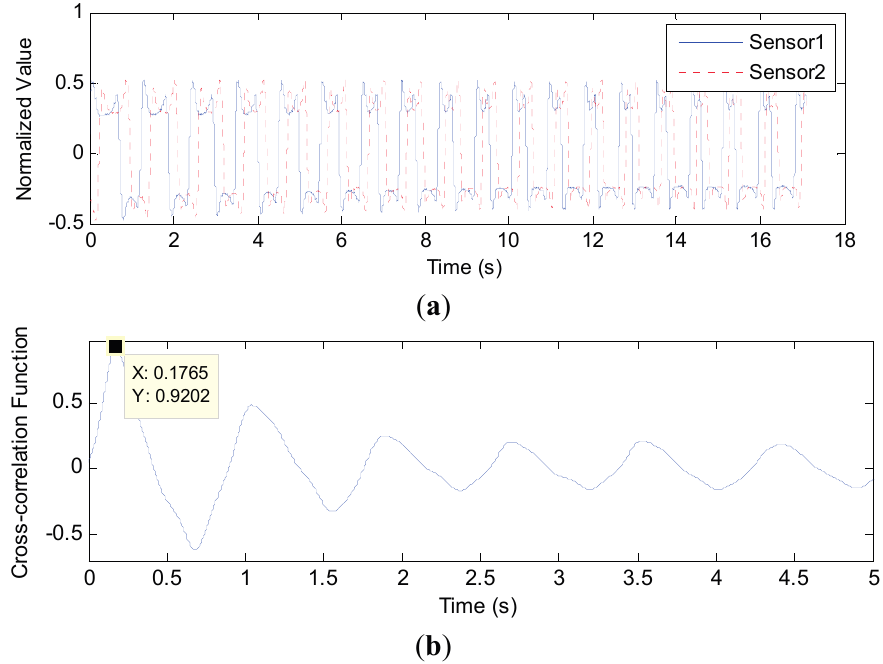
Figure 10. Signal waveforms and the resulting correlation function in 2.65 mm inner diameter pipe with 4.0 mL/min gas flowrate and 4.0 mL/min liquid flowrate: ( a ) Normalized signals from the two capacitance sensors; ( b ) Cross-correlation function between the two signals in